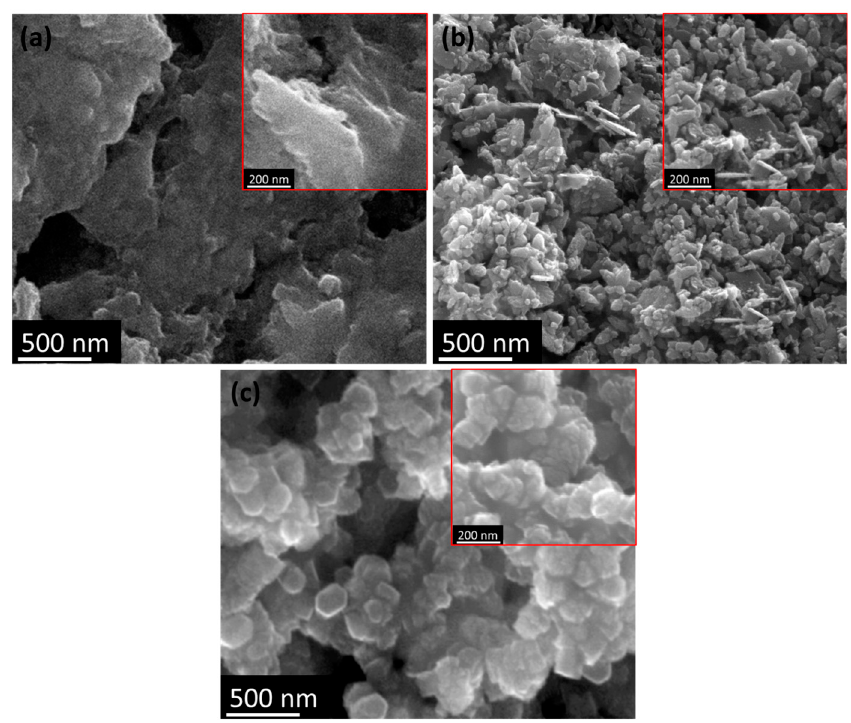
Figure 4. Scanning electron microscopy (SEM) images of ( a ) CS and the ( b ) CS–ZnO and ( c ) CS–ZnO– GO hybrid structures.